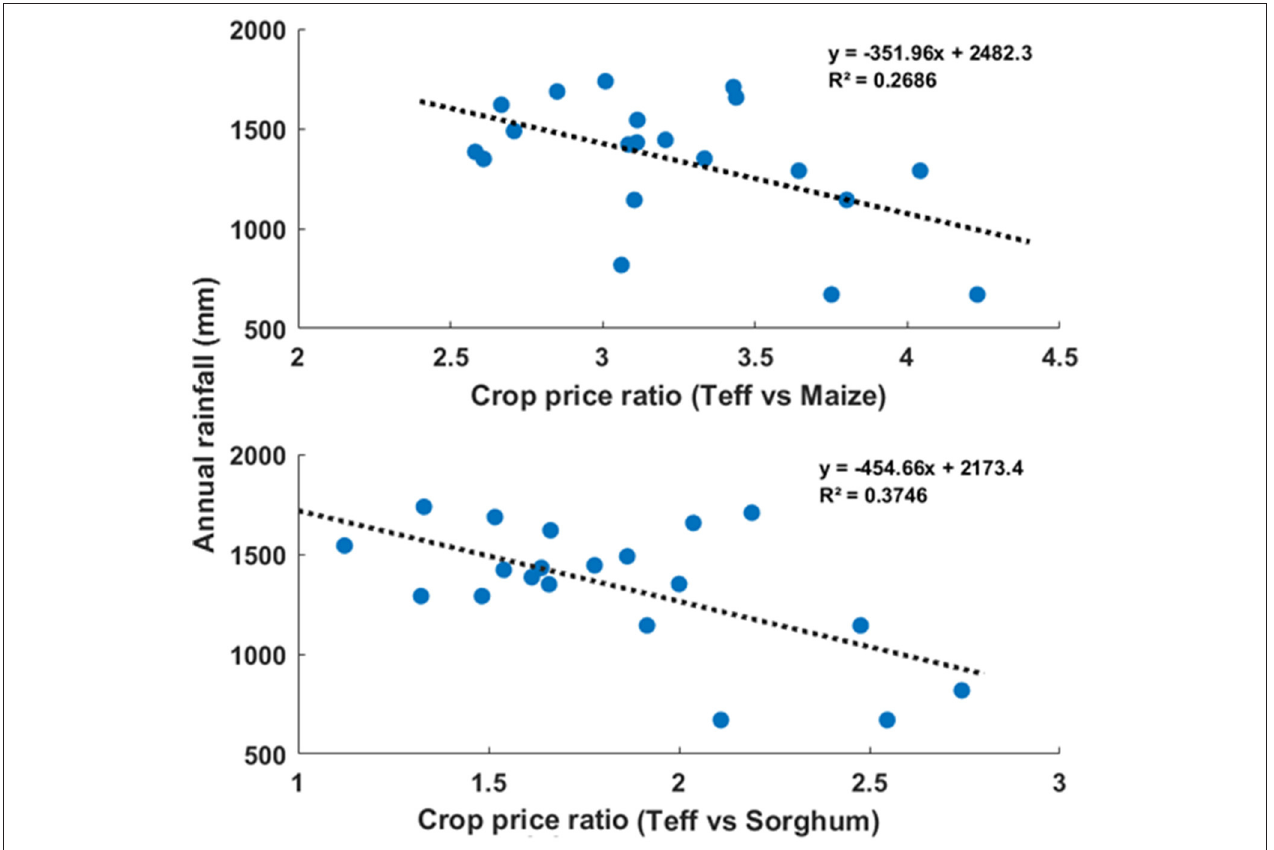
FIGURE 11 | Scatter plots of price ratios of teff and maize, and teff and sorghum, vs. rainfall. Price of Teff relative to the other two crops falls when rainfall